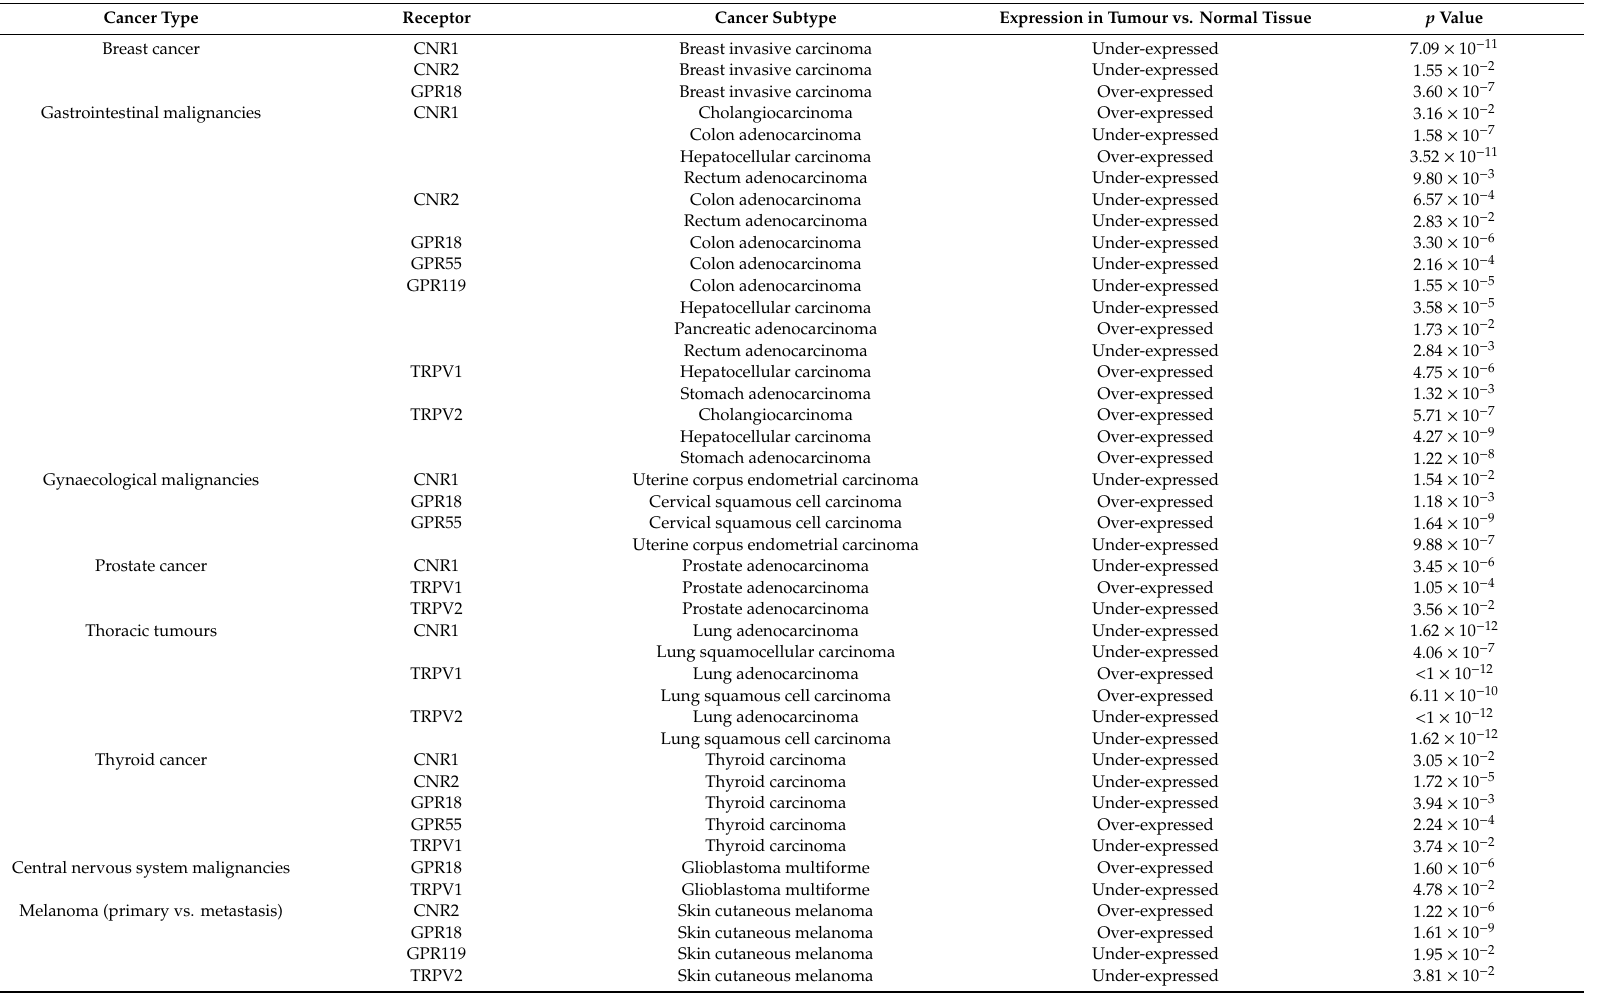
Table 1. Comparison of cannabinoid receptors’ genetic expression in normal vs. tumour tissue according to the UALCAN database [16] analysis of TCGA